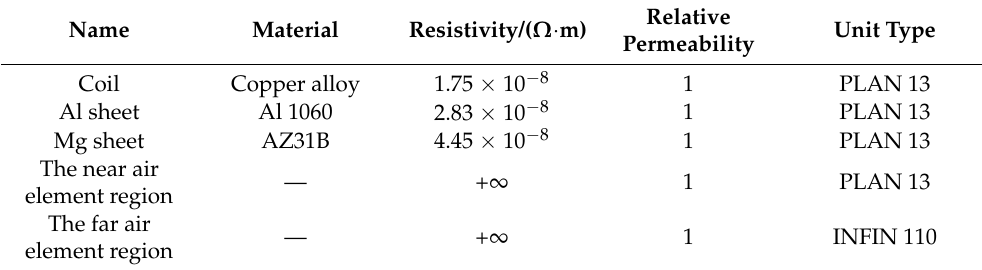
Table 2. Material parameters of 2D electromagnetic field model.